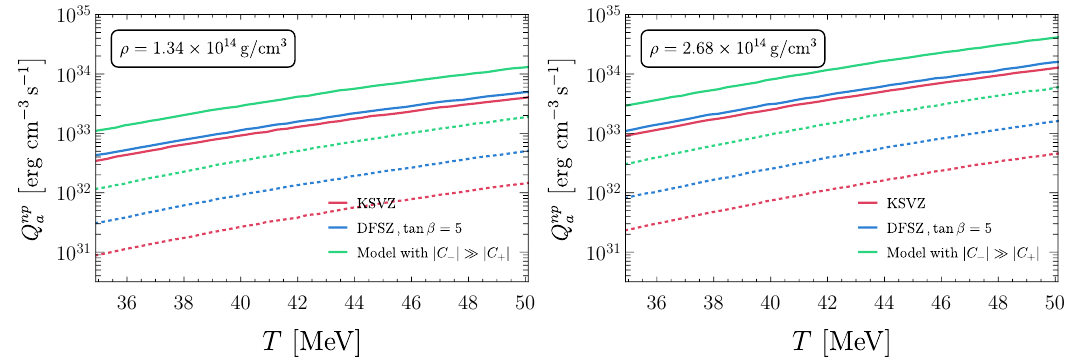
Figure 5 . The axion emissivity Q np a for the three benchmark models considered in figure 3. The solid (dotted) curves correspond to the total value of Q np a (the piece induced only by C aπN